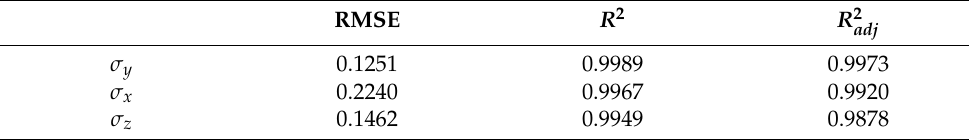
Table 3. Origami honeycomb structure approximation function evaluation